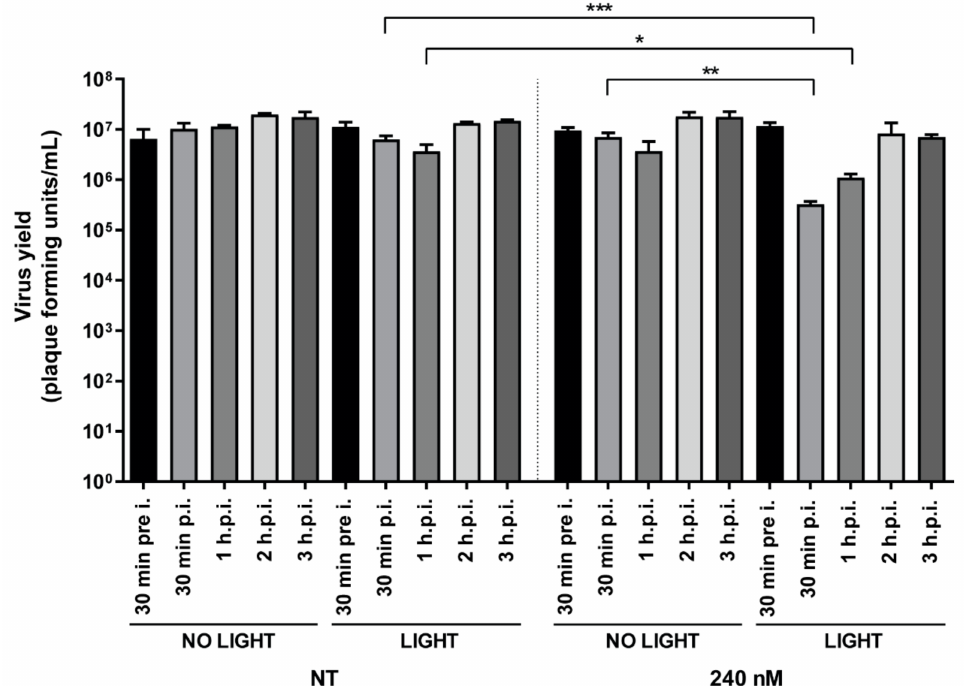
Figure 7. Addition of TMPyP3-C 17 H 35 early in the infection inhibits HSV-1 replication. Vero cells pretreated (30 min prior to infection) with the compound, irradiated and infected, or infected and treated at indicated hours post infection (p. i.). At 18 h after infection, supernatants were collected and the number of plaque-forming units determined by titration. NT: not treated. All samples were tested in triplicate and data were analyzed using unpaired t-test ( p values indicate significant differences; *** p = 0.0006, ** p = 0.0015, * p =